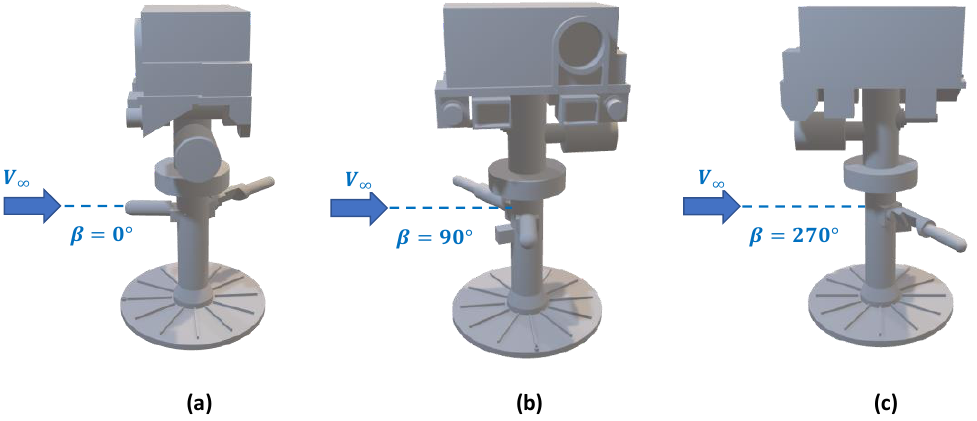
Figure 9. Different slip angles in three orientations of the model: ( a ) orientation at β = 0 ◦ ; ( b ) orientation at β = 90 ◦ ; ( c ) orientation at β = 270 ◦ .